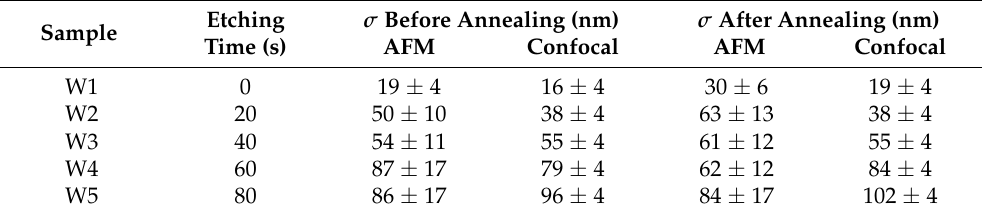
Table 1. RMS roughness ( σ ) before and after annealing for the five studied samples, obtained from AFM and confocal